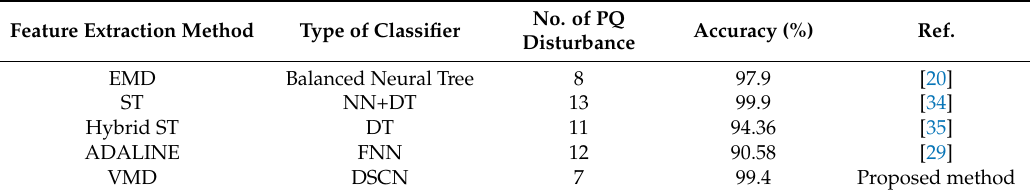
Table 3. The accuracy comparison of the proposed PQ assessment framework with other methods.